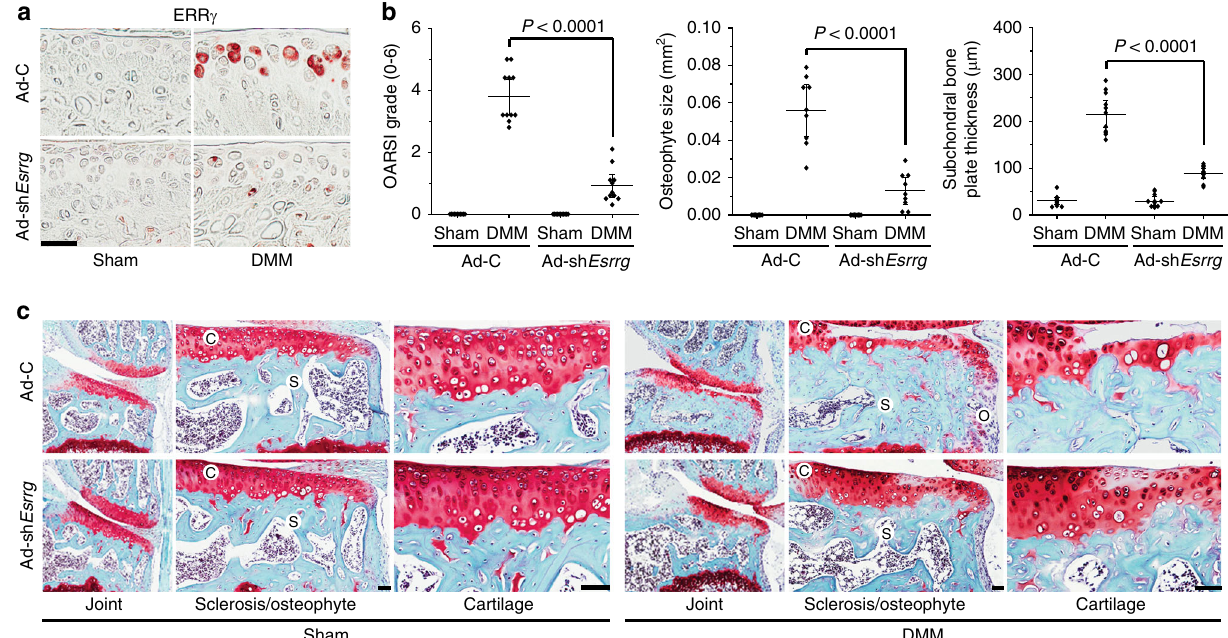
Fig. 6 Silencing of Esrrg in joint tissues abrogates OA pathogenesis in mice. a Immunostaining for ERR γ in cartilage sections of DMM-operated mice given an IA injection of Ad-C or Ad-sh Esrrg . b , c WT mice subjected to sham operation or DMM surgery were IA-injected with Ad-C ( n = 11 mice) as a control or Ad-sh Esrrg ( n = 11 mice) to knockdown ERR γ in joint tissues. Cartilage sections were subjected to safranin-O staining ( c ), and determination of OARSI grade, osteophyte size, and subchondral bone plate thickness at 8 weeks after sham operation or DMM surgery ( b ). Values are presented as means ± s.e. m. Two-tailed t test and Mann – Whitney U test. Scale bar: 50 μ